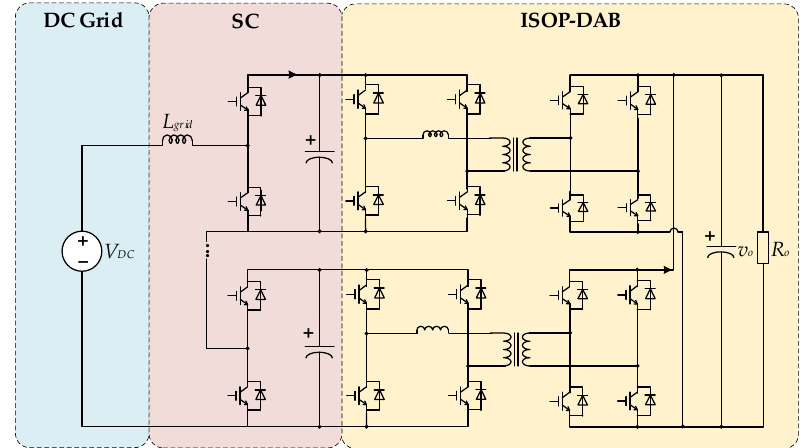
Figure 9. Cascaded structure of the SC-ISOP-DAB.